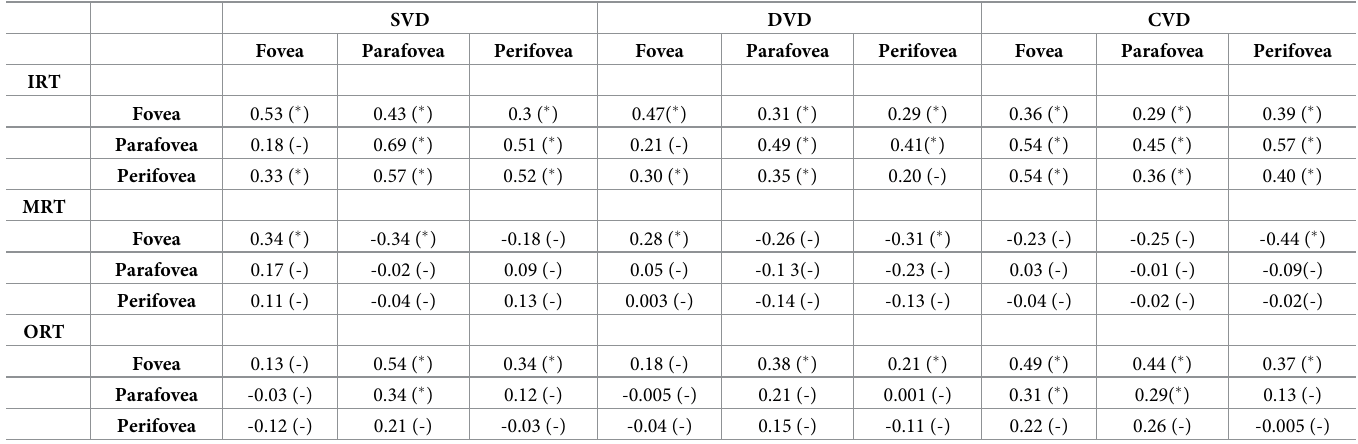
P-values were corrected with the Bonferroni method and the value less than 0.005 considered as significant.Symbols in parenthesis shows P-value (- = not significant,